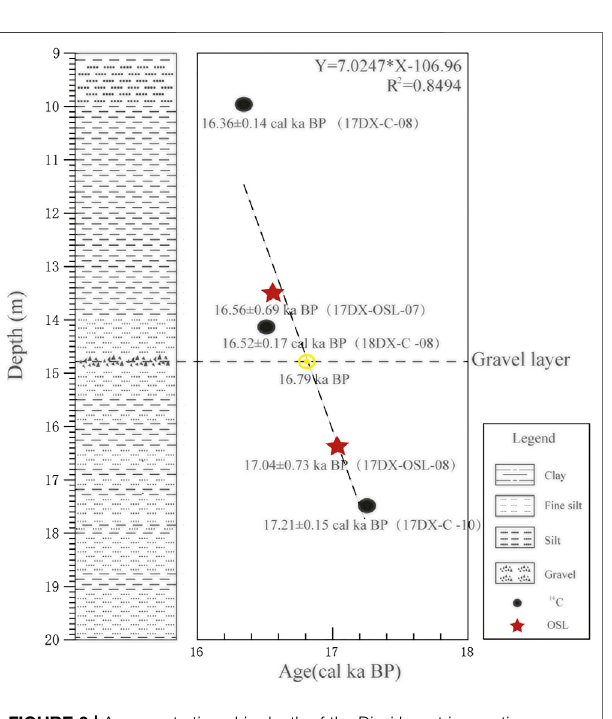
FIGURE 3 | Age vs. stratigraphic depth of the Diexi lacustrine section.